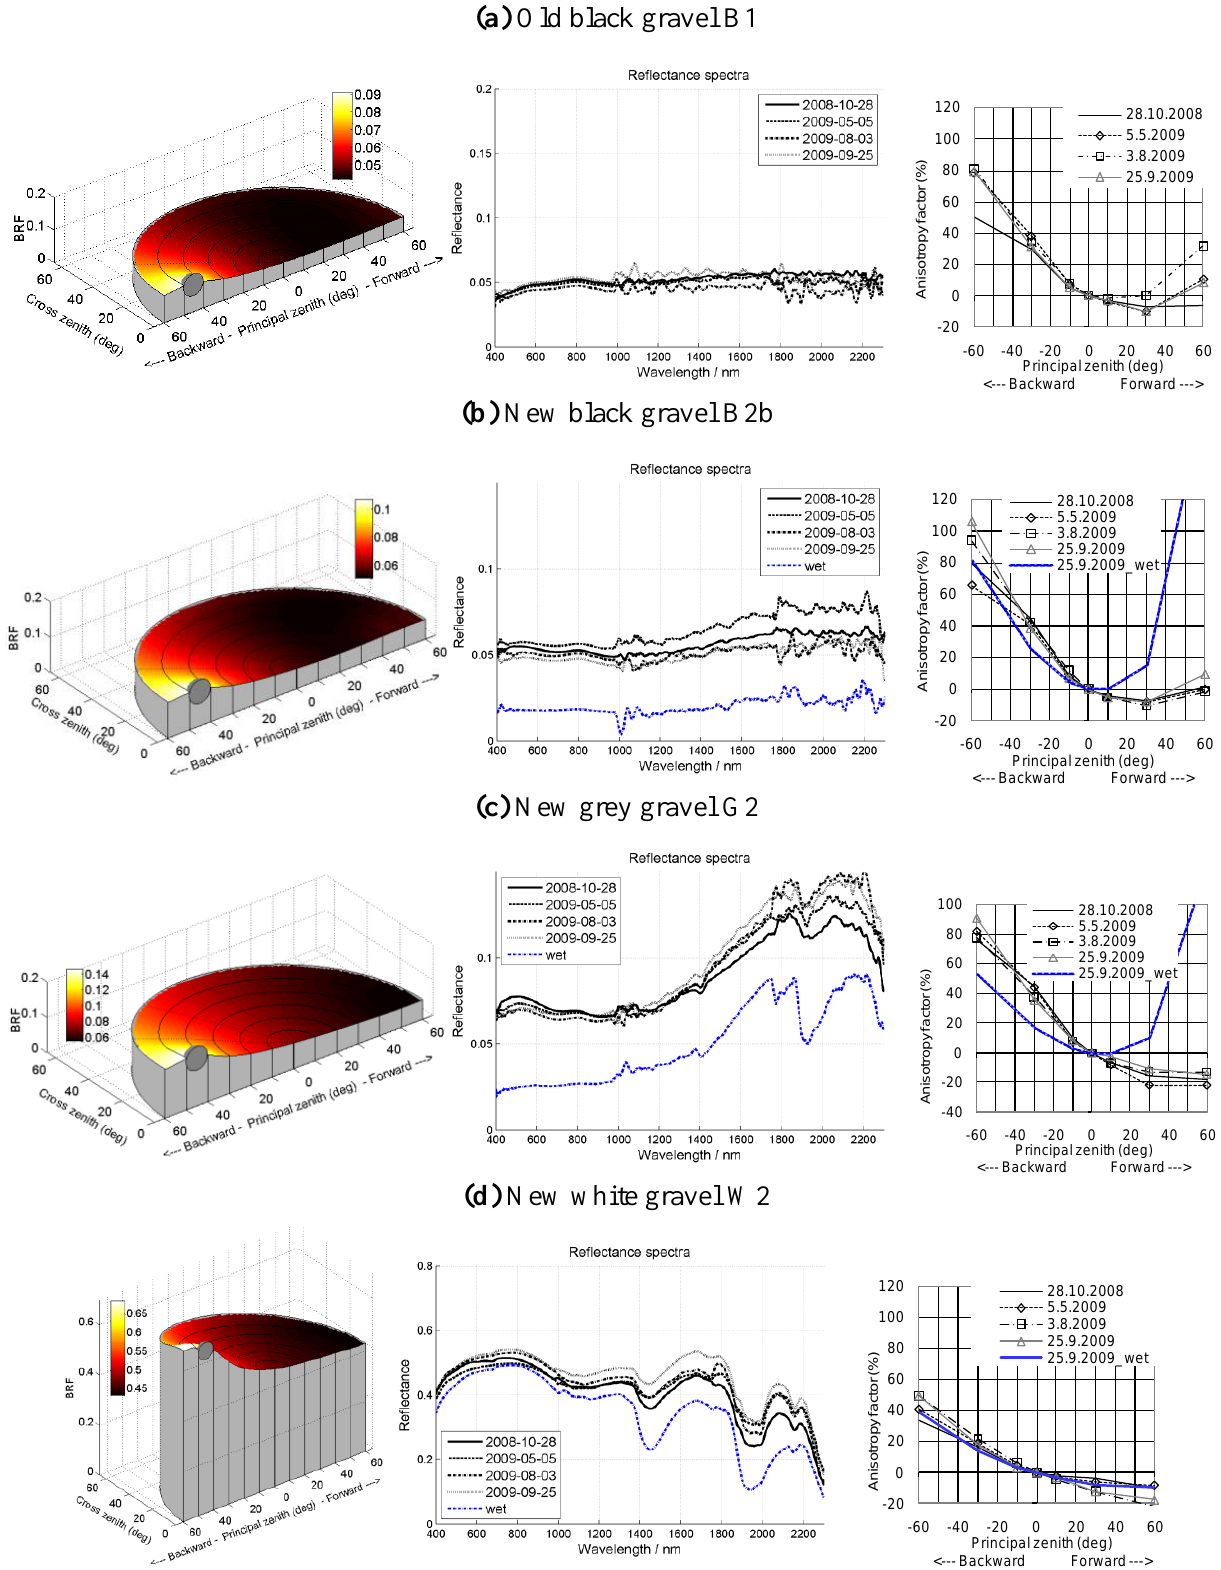
Figure 5. Reflectance characterization of gravels (a) B1, (b) B2b, (c) G2, (d) W2 and (e) R1. Left: The BRF of the green channel (550 ± 25 nm). Middle: the spectra at nadir at different measurement times. Right: Anisotropy factors (Equation 6) at the principal plane at different measurement times. Further details of diagrams are given in the